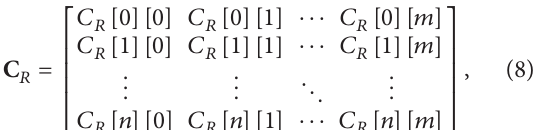
Figure 2: The cyber robot simulator using the designed personality- basedemotionaldecisionmodelandacyberrobotsystem.Userscan change the intelligent engine modules as the purpose of the system